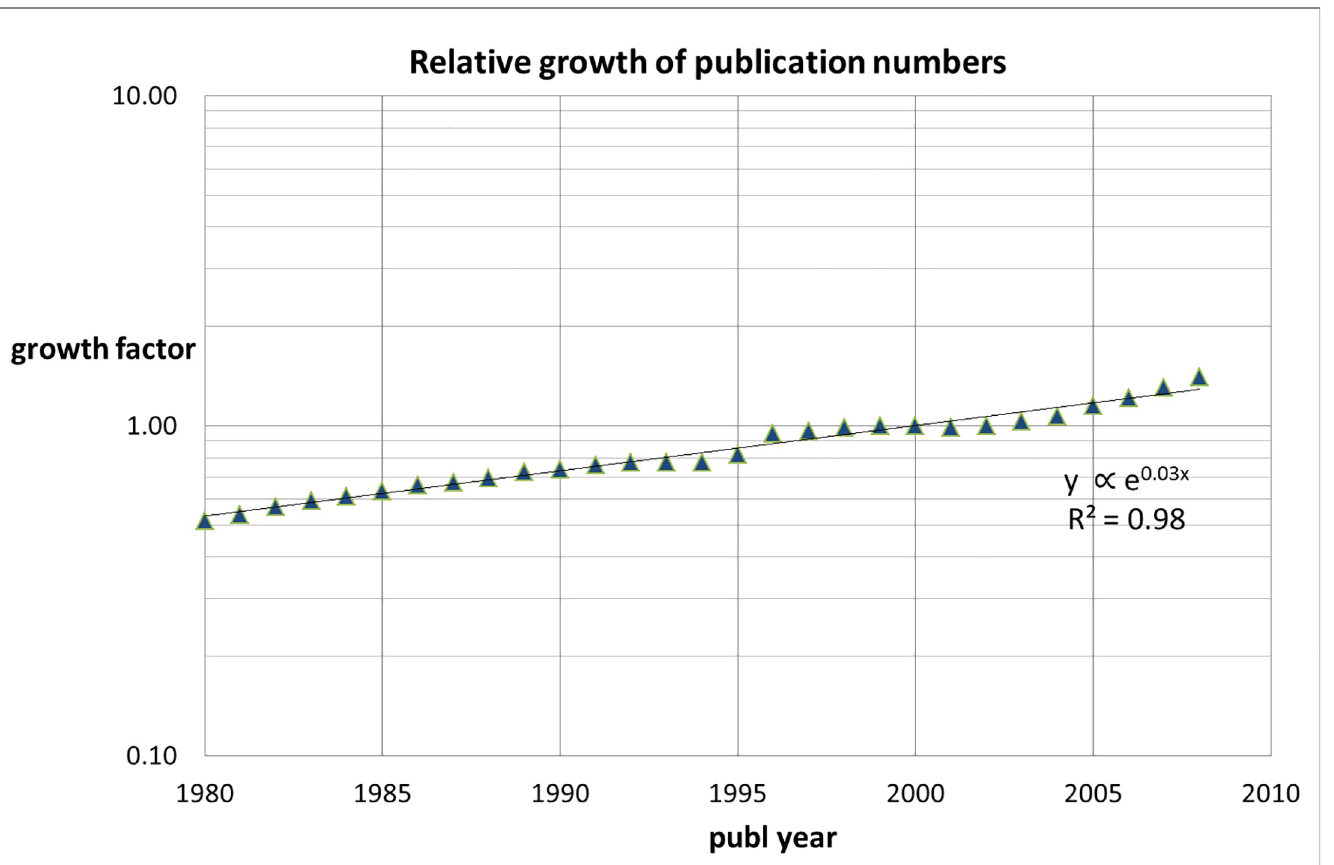
Fig 1. Trend of the number of WoS-covered publications in the medical research fields (index: 2000).